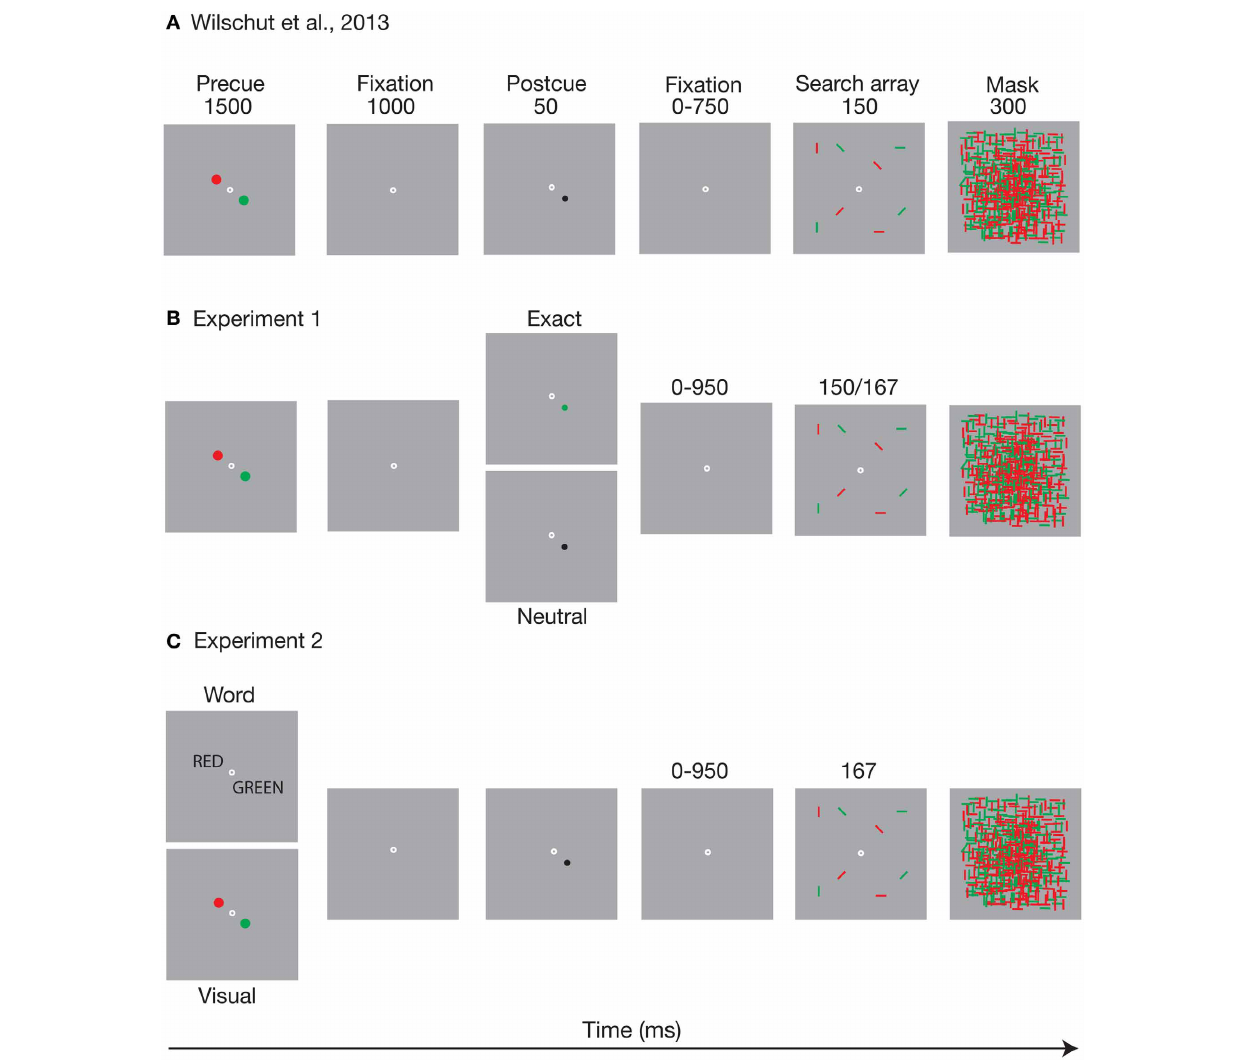
adapted from Wilschut et al. (2013). The time it takes to turn a memory into a template. Copyright by the Association for Research in Vision and Ophthalmology